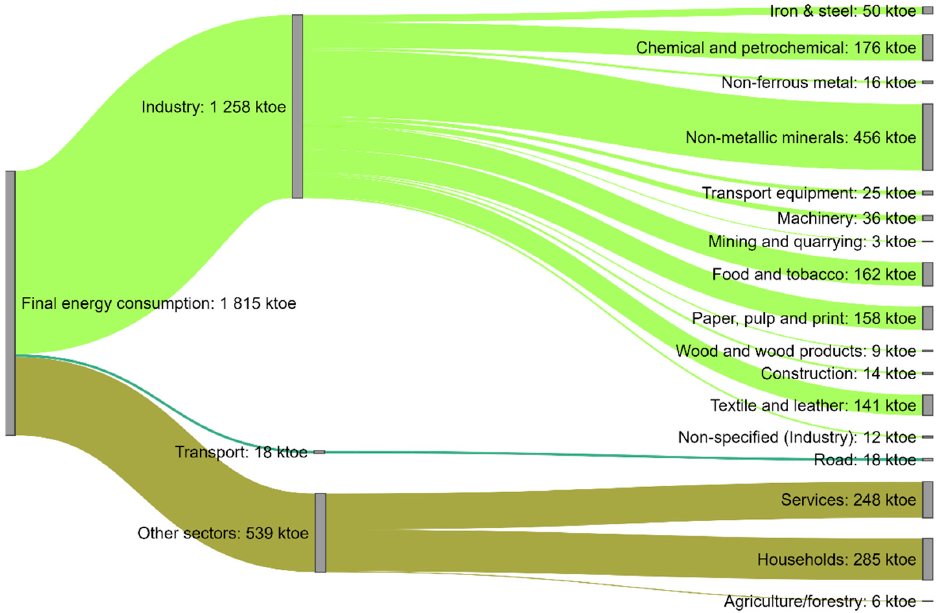
Figure 24. Portuguese energy balance flow for natural gas vector in final energy consumption–2019 data (adopted from Eurostat data).